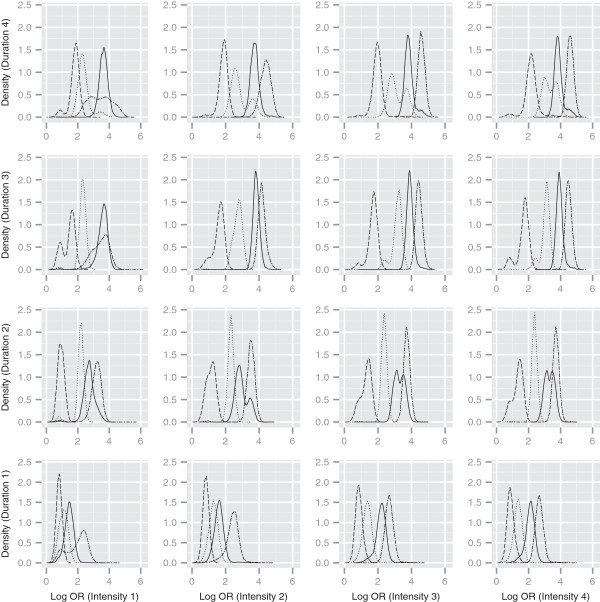
Log odds ratios for intensity, duration and time since cessation combinations. Density estimates of predicted log odds ratios relative to a non-smoking profile, for different intensity and duration combinations. Line types denote different time since cessation categories: dashed=1, dotted=2, solid=3, and double dashed=4. Pack-years treated as missing in pseudo-profiles.